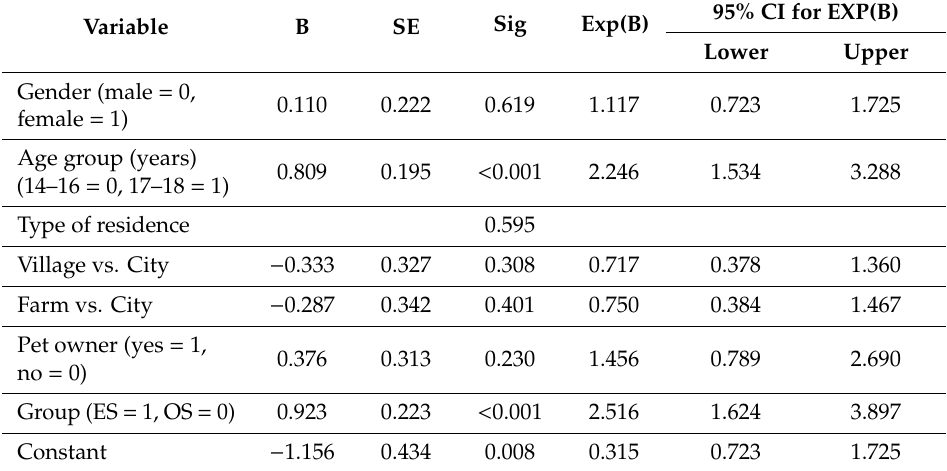
Table 7. Factors influencing the probability of belonging to Cluster 1, with a logistic regression